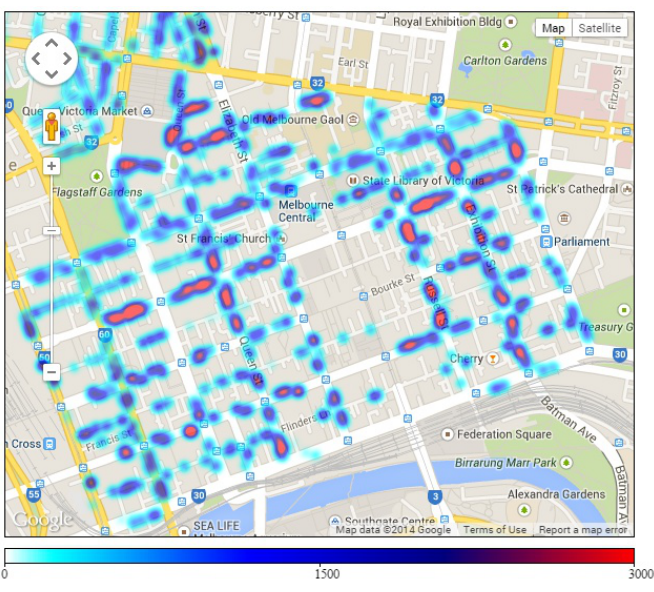
Figure 3. Parking volume map for each street